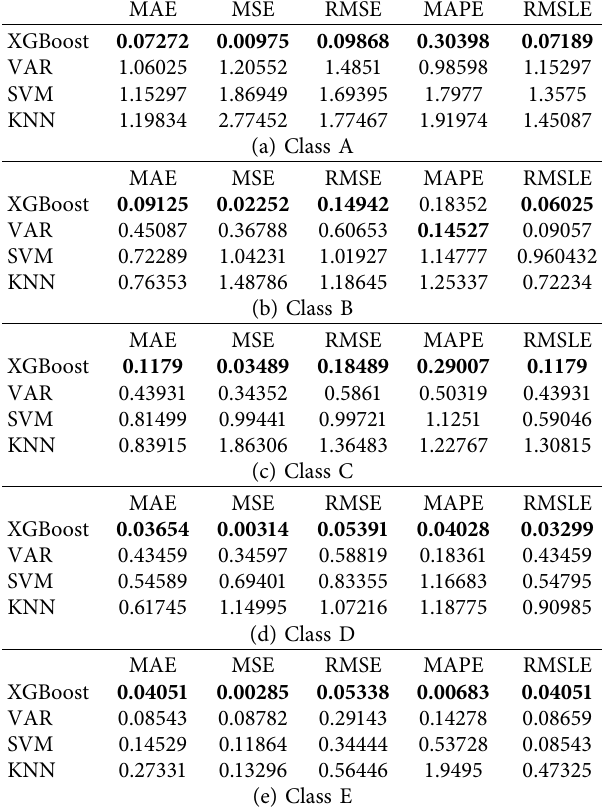
Table 6: Machine learning for univariate time series evaluation results.